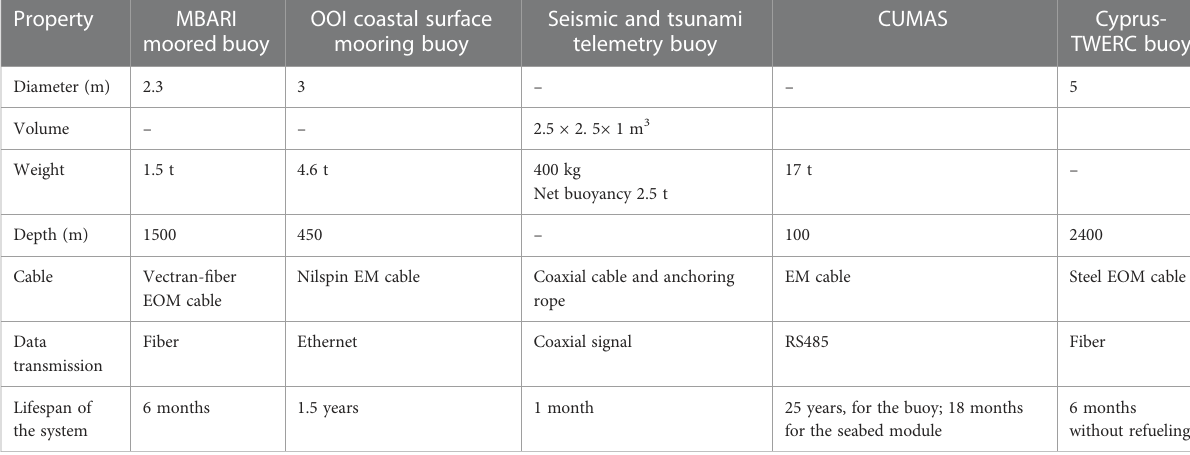
TABLE 1 Speci fi cations of buoy-moored sea fl oor observatory systems.